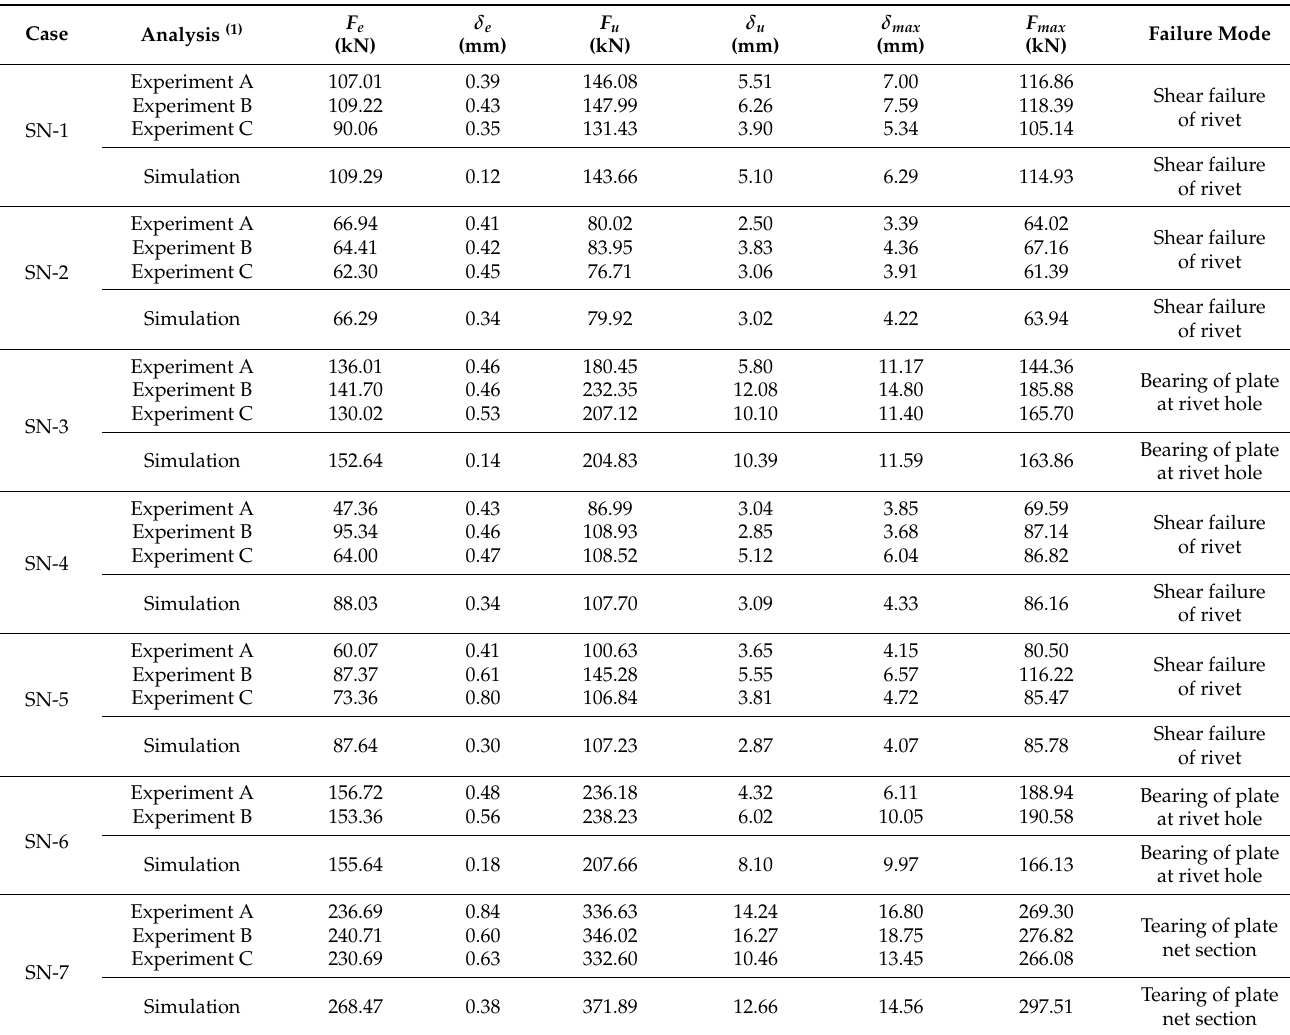
Figure 7. Force vs. displacement curves comparing experimental data with FEA results and deformed configuration at instance of governing mode of failure: ( a ) SN-1, ( b ) SN-2, ( c ) SN-3, ( d ) SN-8, and ( e ) SN-9. Experiments are adapted from [27]. Table 3. Comparison of experimental and FEA simulation results for rivet joint strength parameters.